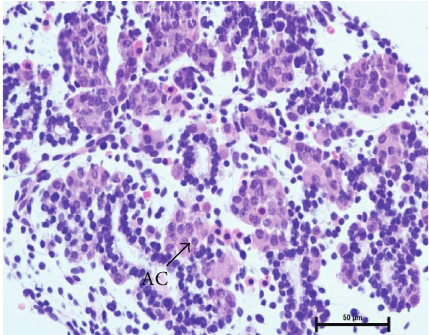
Figure 2: 2.6 cm CVRL (40 days) showing development of acinar cells (AC) from primitive tubules. Hematoxylin and eosin ×